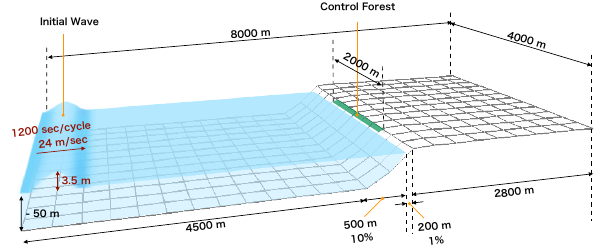
Fig. 4. Topography model for evaluating damping performance of control forests.